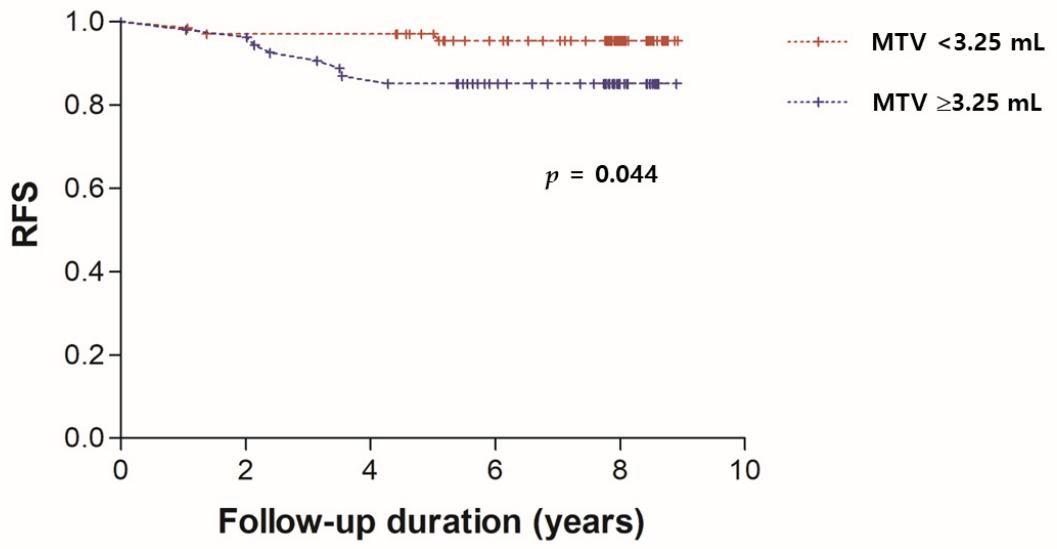
Figure 1. Kaplan–Meier analysis of recurrence-free survival (RFS) according to primary tumor metabolic tumor volume (MTV) value.